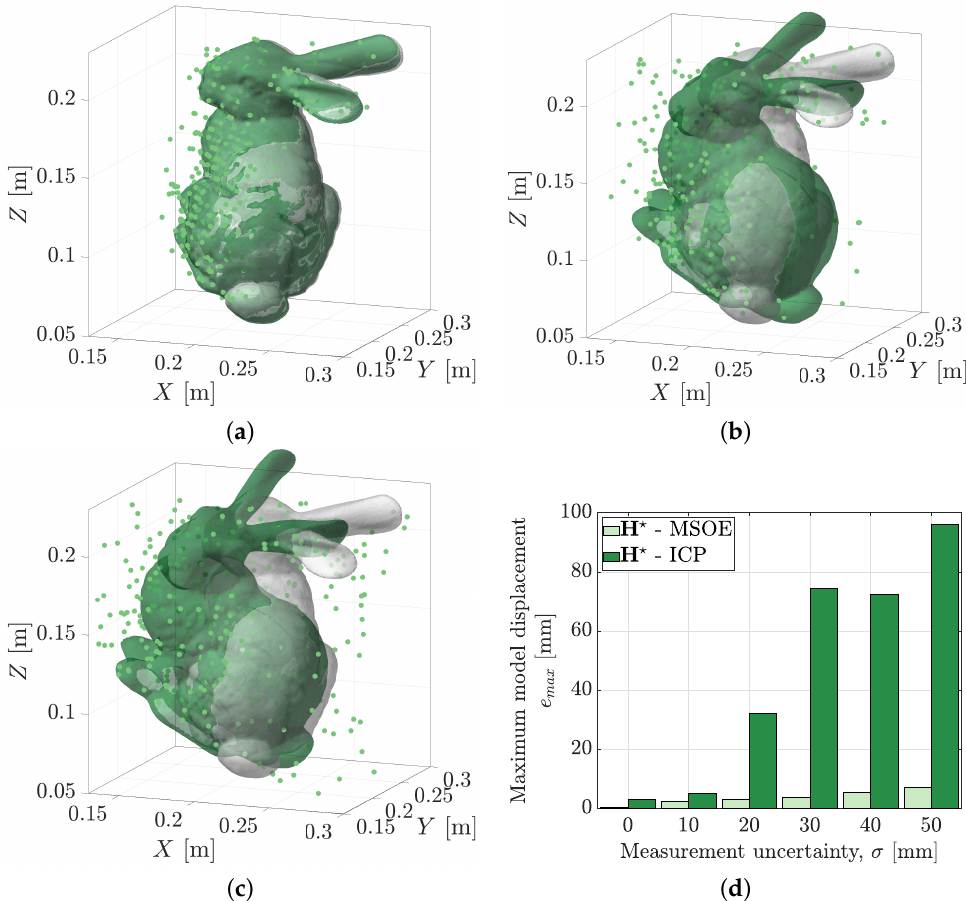
Figure 23. ICP (green) and MSOE (grey) pose solutions obtained for simulated measurement uncer- tainties of: ( a ) σ = 10mm; ( b ) σ = 30mm; ( c ) σ = 50mm. ( d ) Maximum geometric displacement for increasing measurement uncertainty, σ